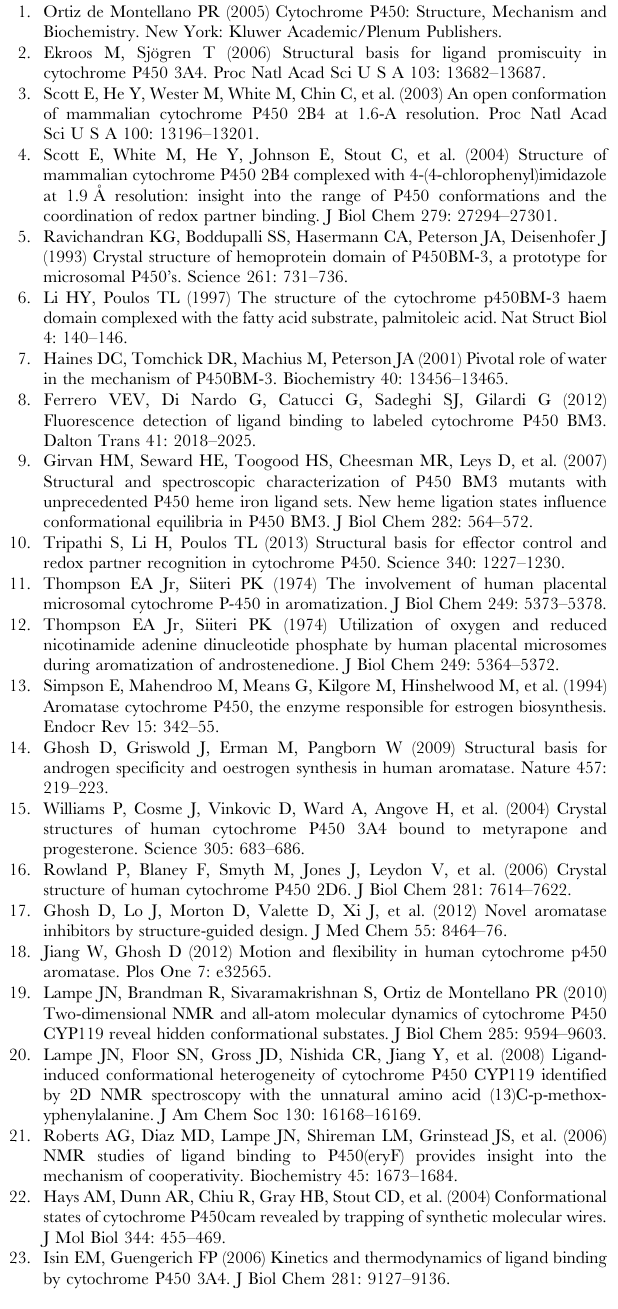
Figure S4 Deuteration of random coil as function of time. A) Data for ligand-free rArom and fitting to a double exponential decay (R 2 =0.9957) and a monophasic exponential decay (dashed line, R 2 = 0.8608). B) rArom in the presence of androstenedione with fitting to a biphasic exponential decay (solid line, R 2 = 0.9976) and a monophasic exponential decay (dashed line, R 2 = 0.8403). C) rArom in the presence of anastrozole with